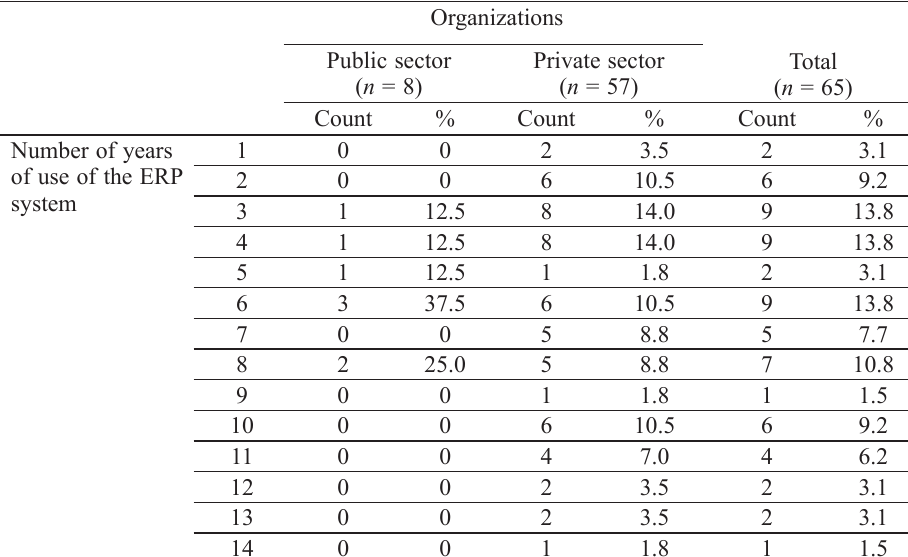
Table 4. Key Features of the implementation